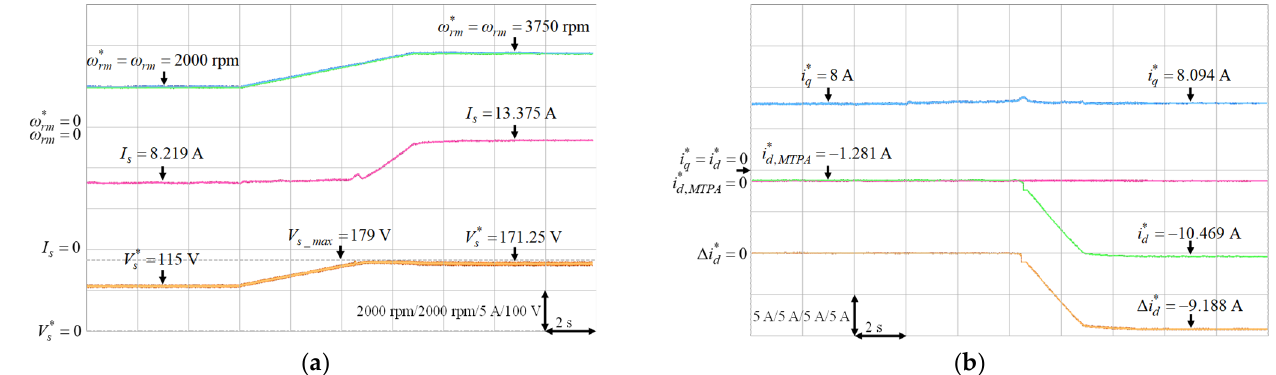
Figure 23. Experimental results of FW control from 2000 rpm to 3750 rpm under 5.07 Nm load torque: ( a ) mechanical speed command, mechanical speed, stator current and stator voltage command; ( b ) q -axis current command, d -axis current command of MTPA, d -axis current command and variation of d -axis current command.